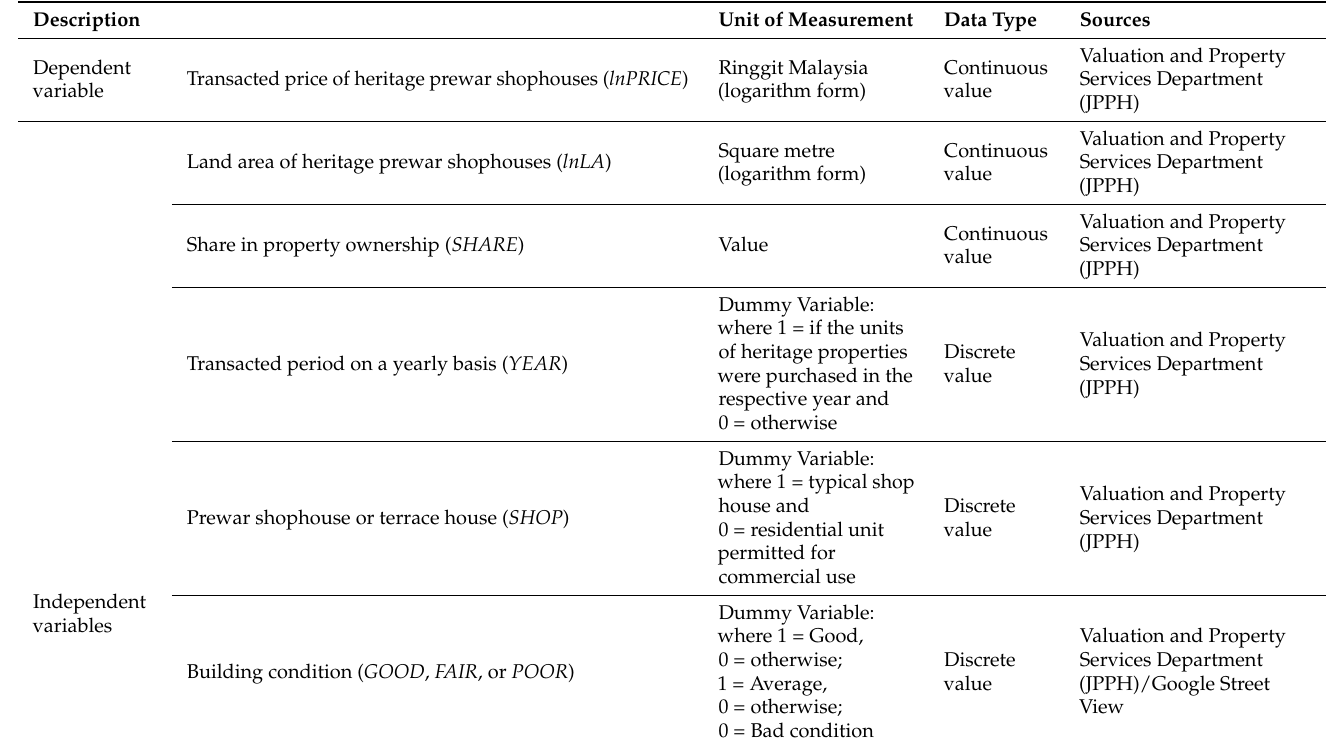
Table 2. Data Quantification of